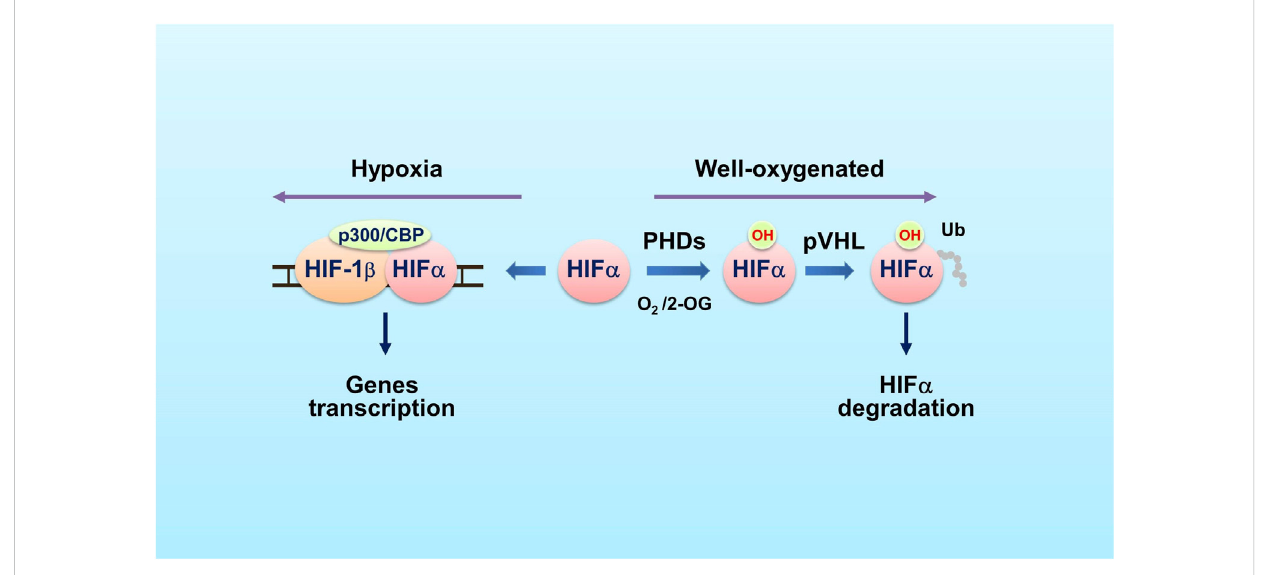
FIGURE 1 The PHD-HIF oxygen-sensing system. In well oxygenated cells (schematic on the right side), PHDs hydroxylate HIF α on speci fi c proline residues using O 2 and 2-OG as co-substrates. The E3 ubiquitin ligase pVHL recognizes the hydroxylated HIF α and mediates HIF α ubiquitination and proteasomal degradation. In hypoxic cells (left side), the PHDs ’ prolyl hydroxylase activity is inhibited, leading to HIF α accumulation. HIF α then dimerizes with HIF-1 β andrecruitsCBPandp300co-factors.Thecomplexbindstohypoxiaresponseelement(HRE)withinorneartargetgenestoactivatetranscriptionof these genes. Abbreviations used: HIF, hypoxia-inducible factor; PHD, prolyl hydroxylase; Ub, ubiquitin; pVHL, the von Hippel-Lindau protein; 2-OG, 2-